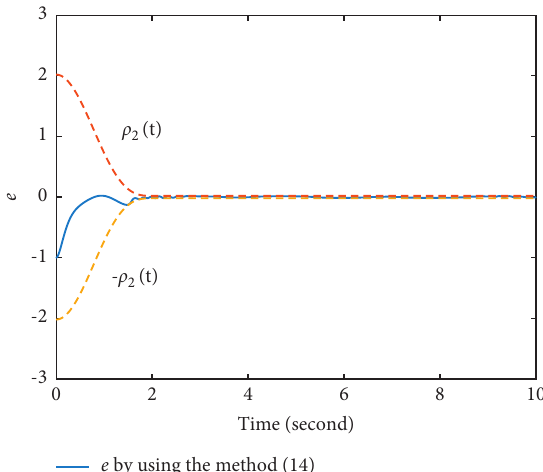
Figure 7: Time response trajectory of tracking error e by using method (14) under ρ